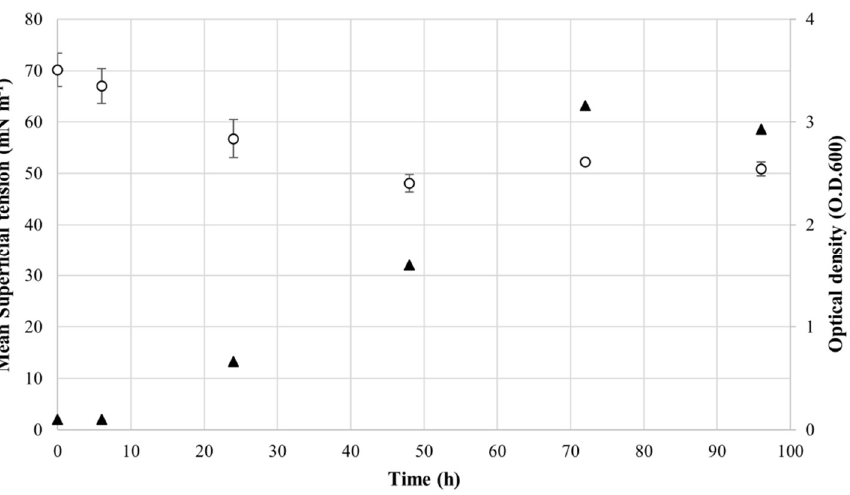
Figure 2. Analysis of the surface tension of CFS from R . opacus R7 grown on mineral medium supplemented with naphthalene. R . opacus R7 growth was measured by optical density (O.D. 600 ) (black triangles) and the surface tension values of CFS were obtained by tensiometer analysis (white circles). Mean values are presented obtained through triplicate treatments.